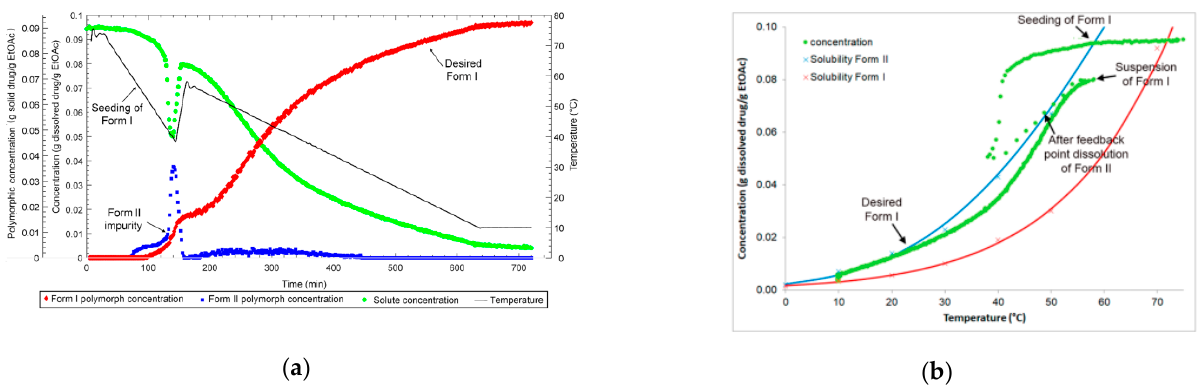
Figure 6. Schematic diagram of the experimental setup ( a ); the detailed strategy of the feedback control ( b ). (Caption and figure reprinted with permission from Refrence [36]).